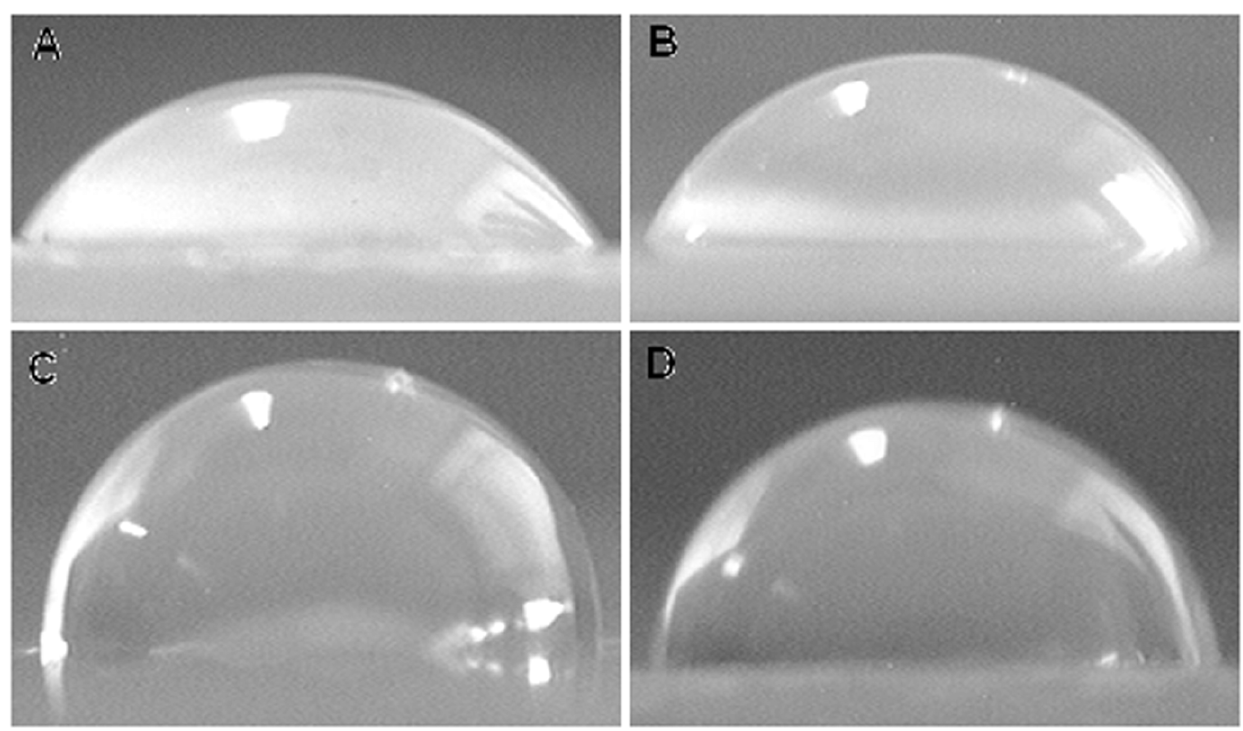
Figure 5. Contact angle images of the synthesized LDHs. A: S-Ni 0.1 MgAl, B: S-Ni 0.1 MgAl-Nd, C: S-Ni 0.1 MgAl-Ce and D: S-Ni 0.1 MgAl-La.